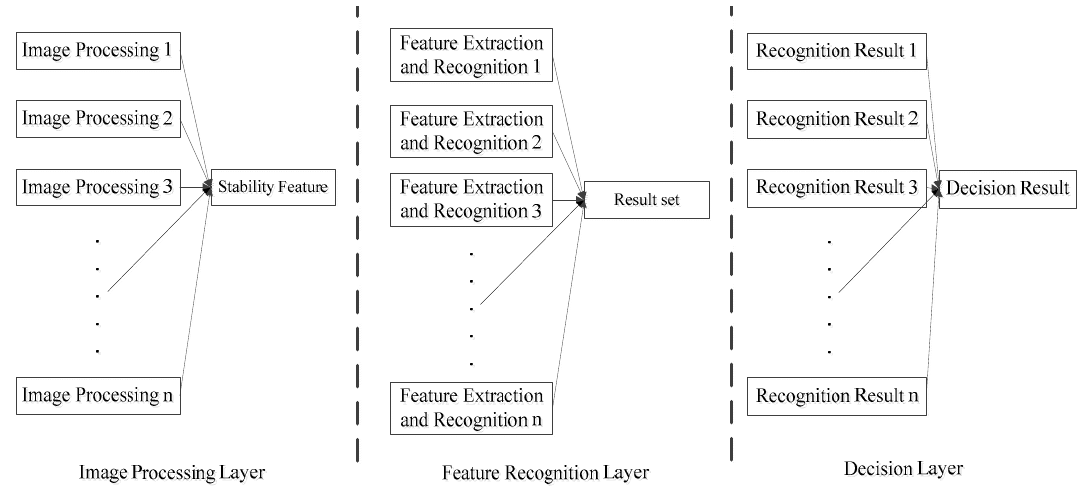
Figure 2. Multi-algorithm parallel integration model structure.